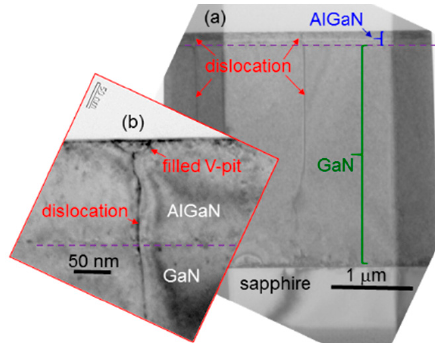
Figure 5. ( a ) Transmission electron microscopy (TEM) image showing that two dislocations extend from the GaN template into the Mg-doped AlGaN layer in sample uf-p. ( b ) Another TEM image of sample uf-p showing that a dislocation ends at the top surface with a filled V-pit.